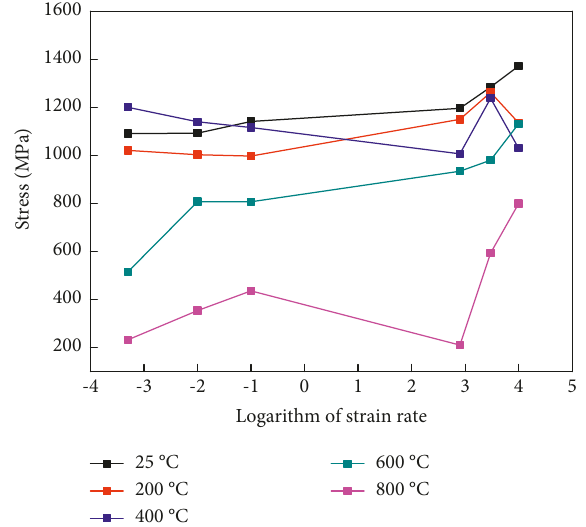
Figure 5: Effects of the strain rate on the flow stress of U71Mn rail steel at ε �